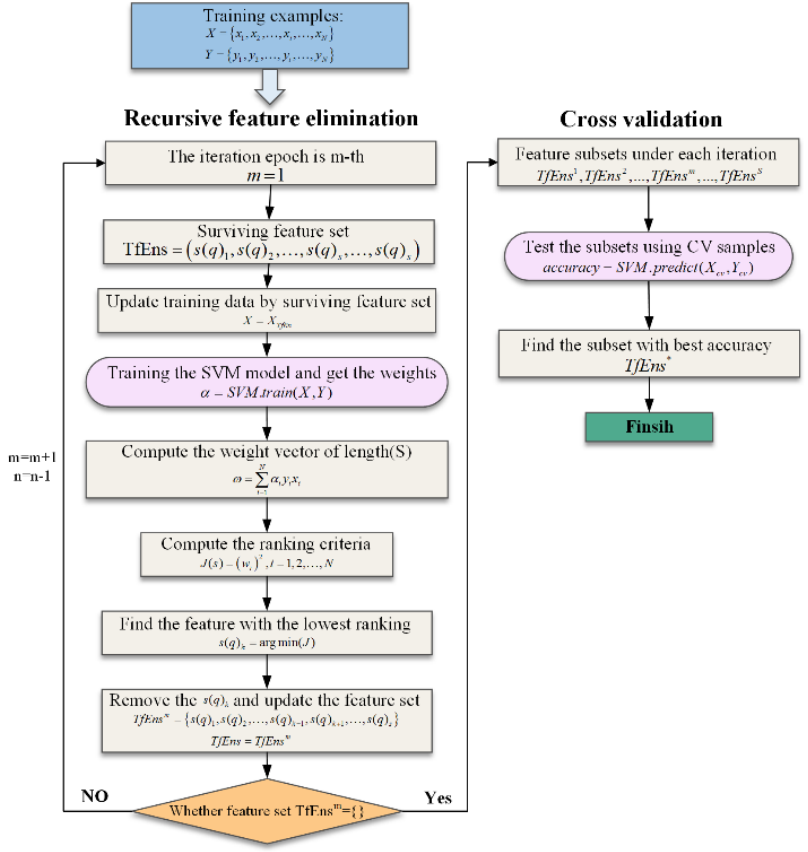
Figure 4. The flow chart of recursive feature elimination (RFE)-based feature selection.